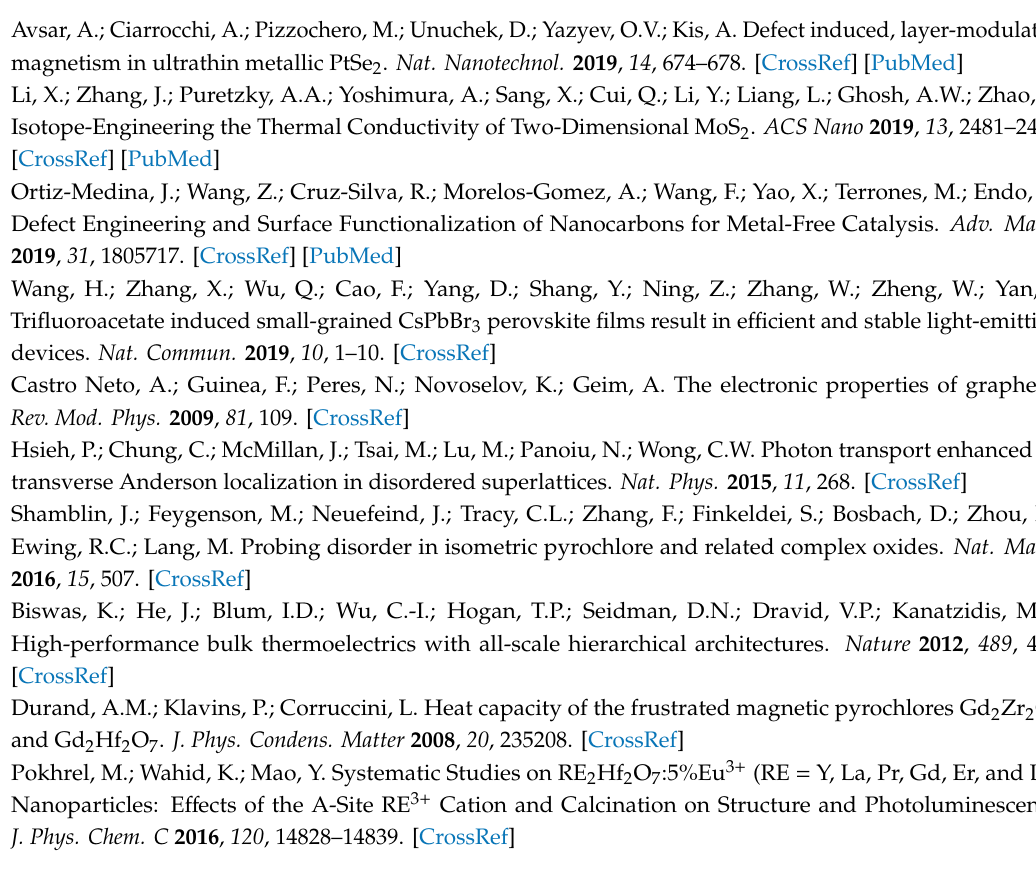
Supplementary Materials: The following are available online. SEM images of the as-synthesized Gd 2 Hf 2 O 7 nanocrystals and samples calcined at 1000 ◦ C, 1250 ◦ C, and 1500 ◦ C for six hours in the air, samples of CRYSTAL17 supplementary